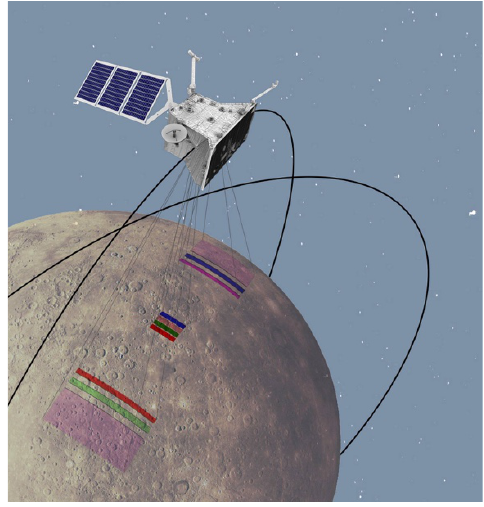
Figure 2. Impression of STC and HRIC on